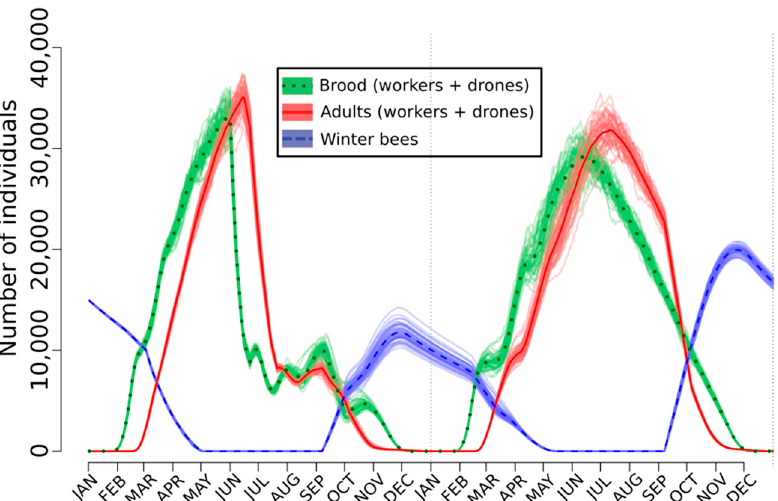
Figure 2. Effect of a decrease in the efficacy of the nurses on the population dynamics of A. mellifera simulated with the agent ‐ based model SimBeePop.